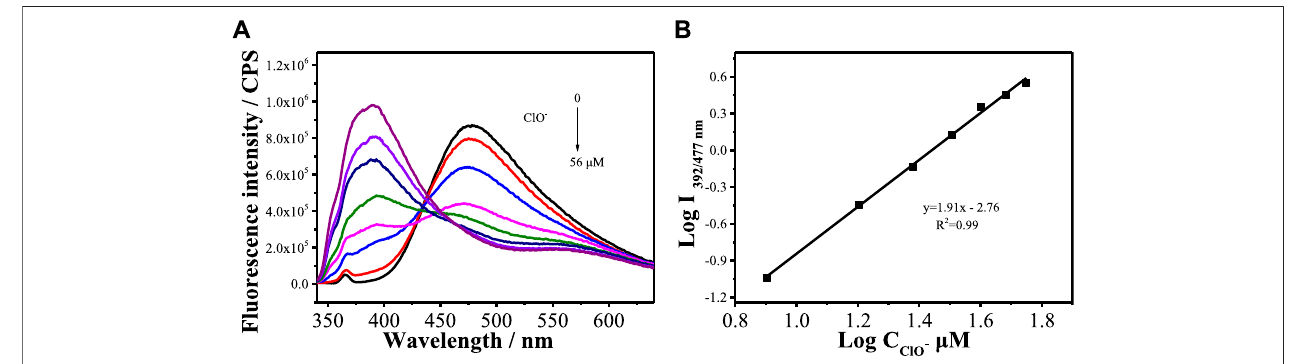
FIGURE 2 | (A) Fluorescence spectra of MBI-OMe (2.0 µM) in PBS buffer (pH = 7.4) containing different concentrations of ClO − (0 – 56 μ M). (B) Linear relationship between MBI-OMe fl uorescence intensity and ClO − concentration.